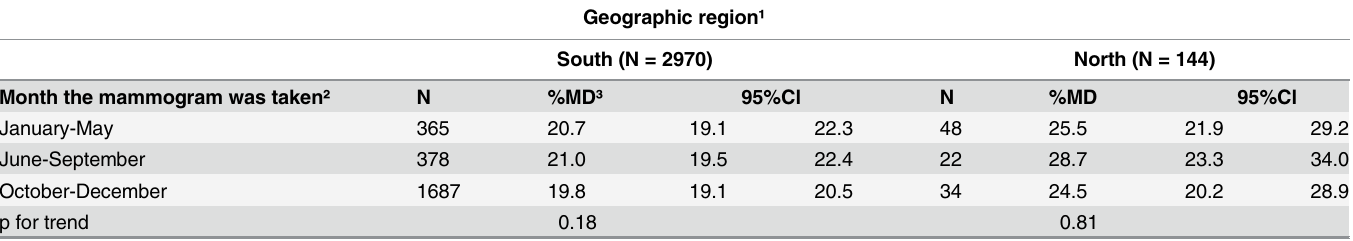
Table 4. Month the mammogram was taken and percent mammographic density (%MD) by geographic region of usual area of residence. Geographic region¹